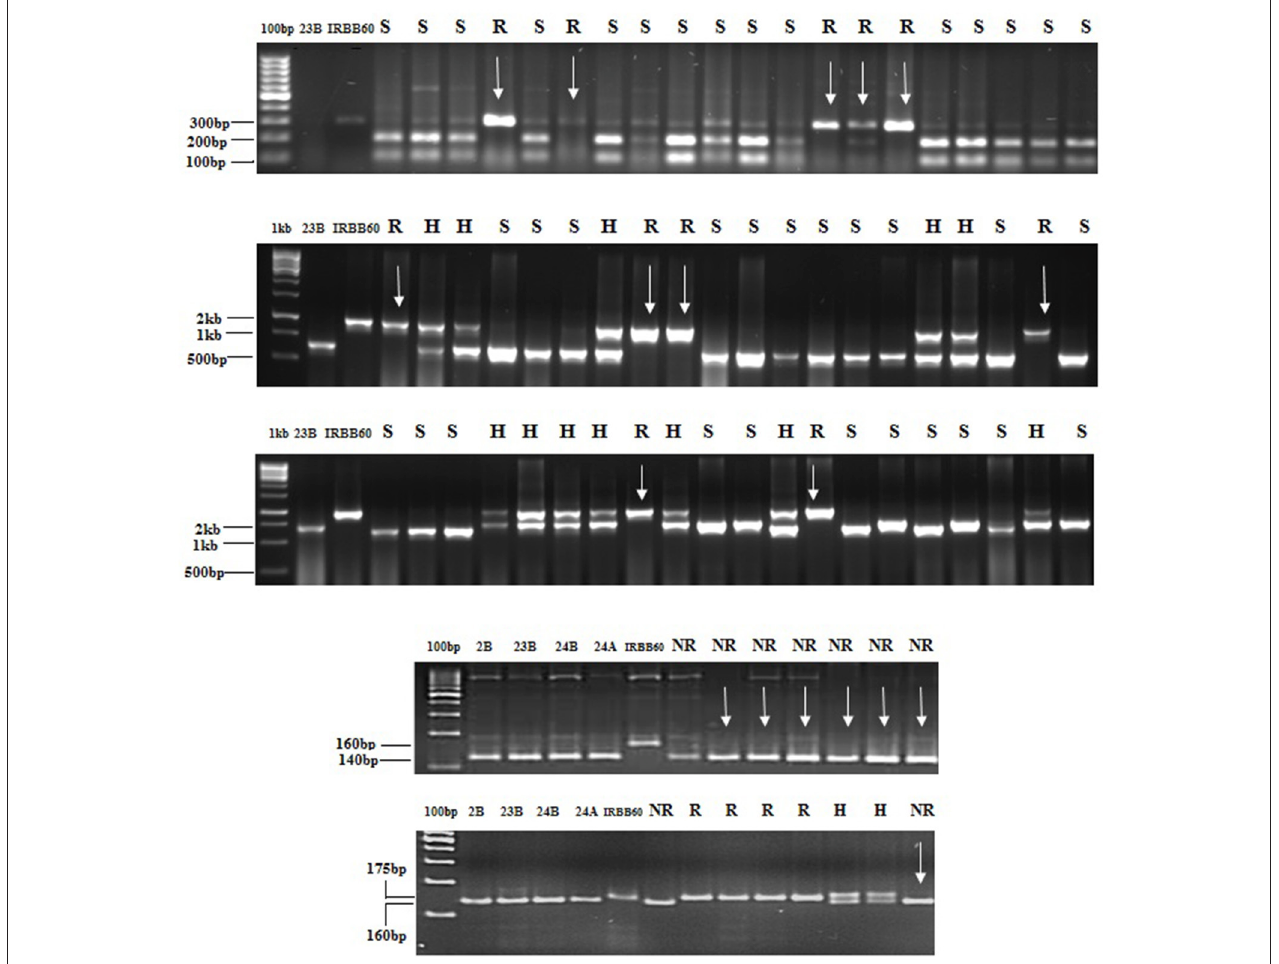
FIGURE 1 | Foreground selection in progenies. PCR amplification of BC 2 F 2 plants of CO 23B × IRBB 60 cross combination (1) xa5_1F, xa5_1R restricted with the enzyme BsrI to detect polymorphism (2) with xa13 (3) with Xa21 (4) DRRM-RF3-10 maker for Rf 3 genes (5) RM 6100 marker for Rf 4 In figure, R, H, S